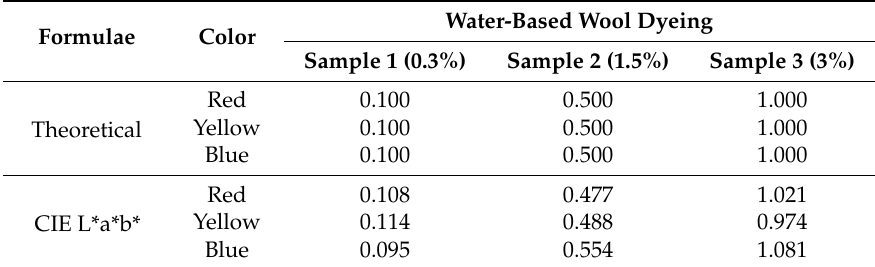
Table 7. Color-matching recipes of water-dyed standard wool